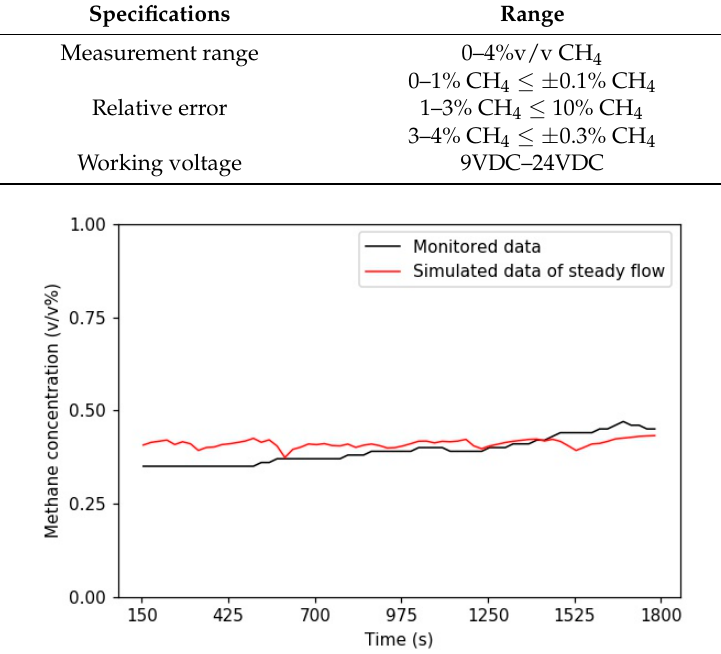
Figure 12. Comparison of the simulated data with field monitored data.